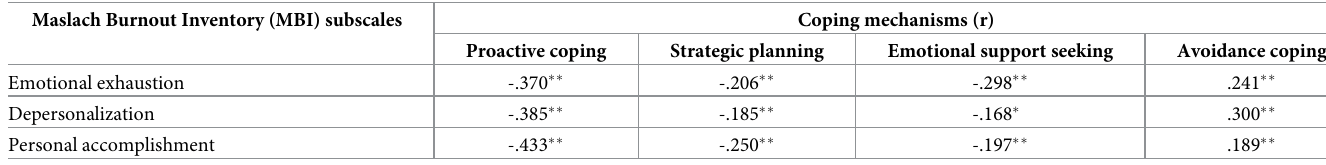
Table 2. Correlation between coping mechanisms and Maslach Burnout Inventory (MBI)